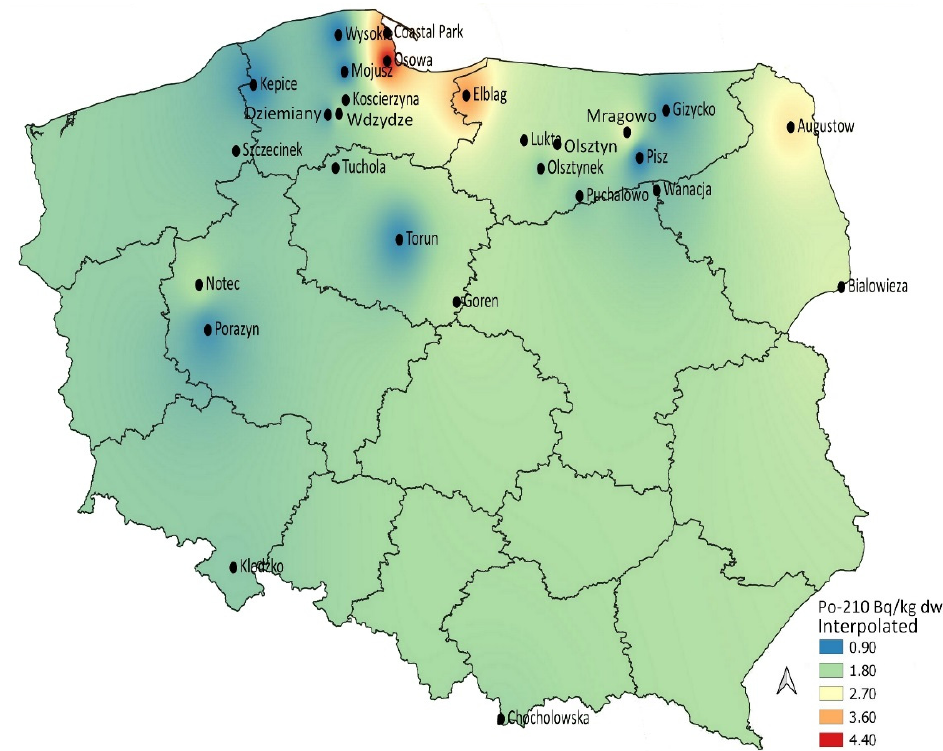
Figure 1. Interpolation map for 210 Po activity concentrations in boletes.